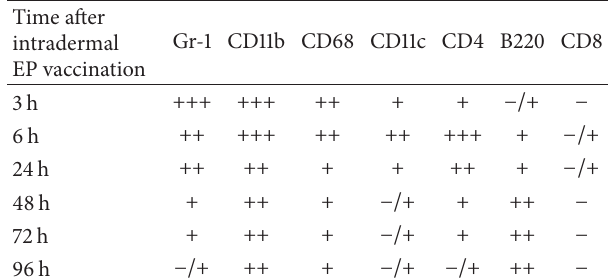
Table 1: Semiquantitative analysis of inflammatory cells present in the skin of BALB/c mice from 3 to 96 hours after pVAX-EGFP vaccination followed by